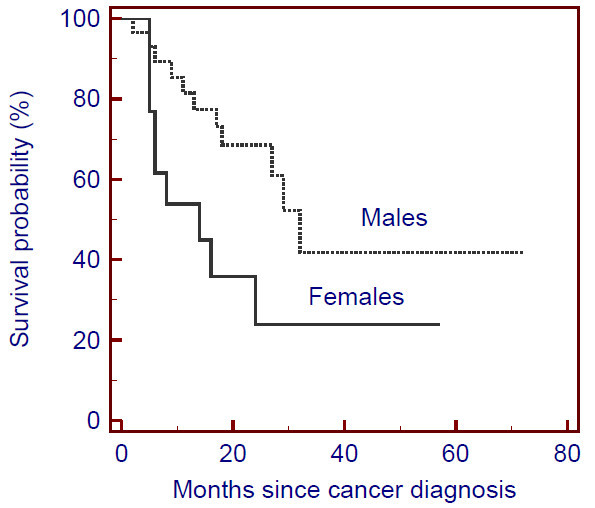
Survival after cancer diagnosis. Survival after cancer diagnosis is lower for women compared to men (14 vs 32 months; p = 0,037, Logrank test).